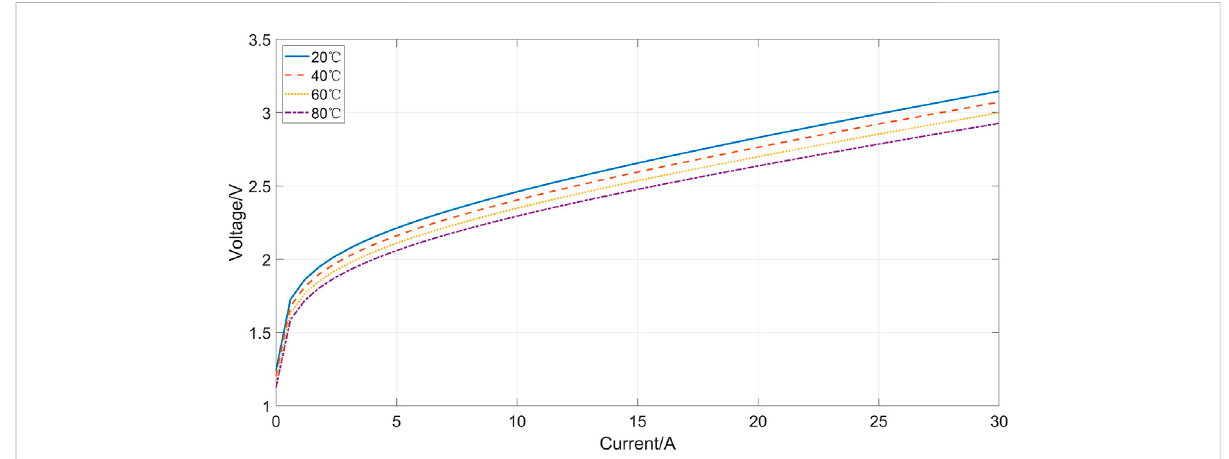
FIGURE 7 U-I characteristic curve of electrolytic cell at different temperatures.